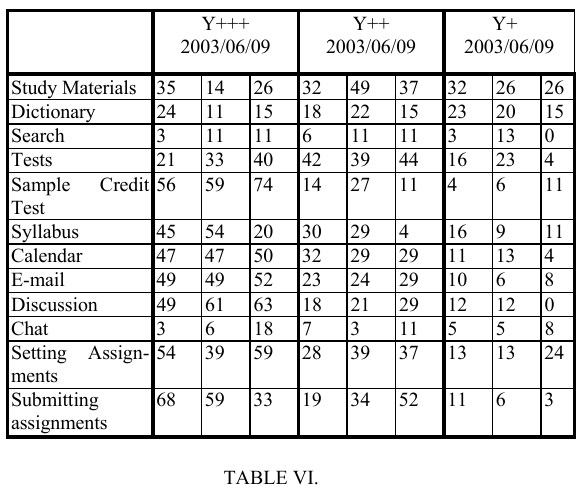
TABLE V. E VALUATION OF STUDENTS ´ SATISFACTION WITH LMS TOOLS (%)